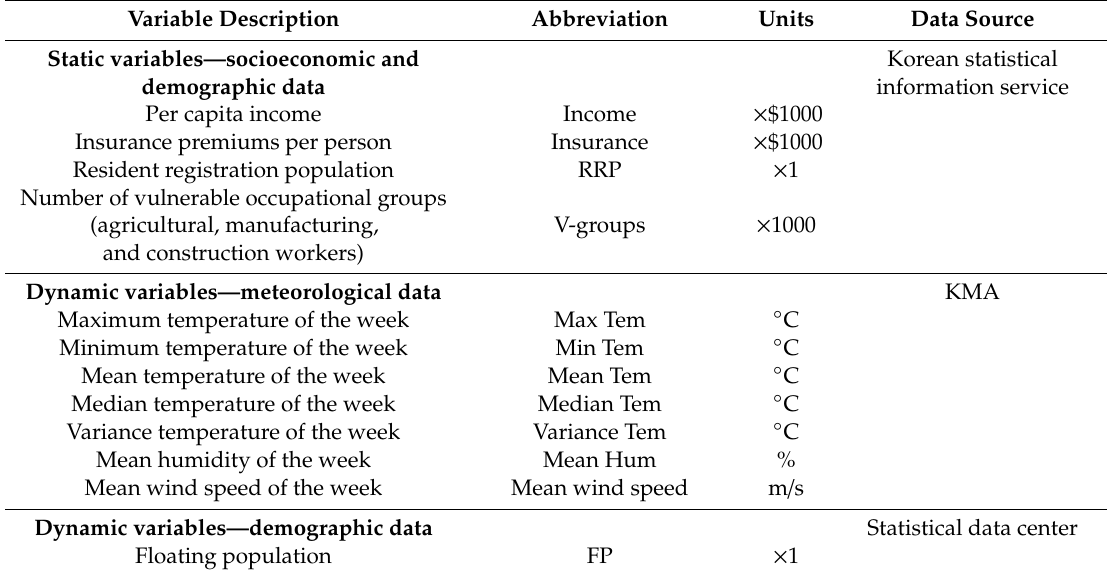
Table 1. Descriptions of variables to predict the number of heatwave-related